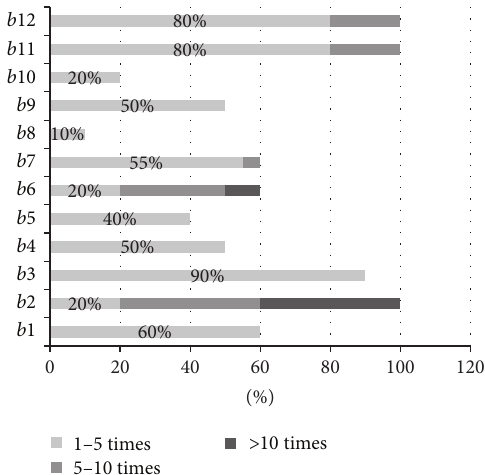
Figure 4: Learners’ online learning behavior statistics.